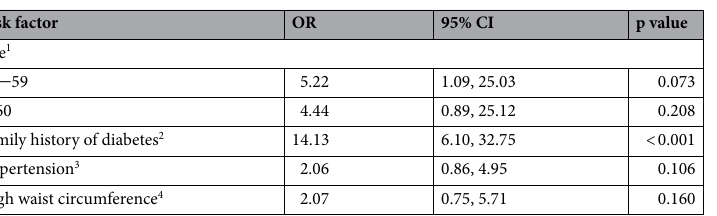
Table 2. Factors associated with T2D using multivariable logistic regression models. OR odds ratio, CI confidence interval, T2D type 2 diabetes. 1 Reference group = subjects aged 20 ‒ 39 years. 2 Based on immediate family members (father, mother, sister, or brother). Reference group = no family history of diabetes. 3 Classified as hypertensive (prior diagnosis of hypertension or systolic blood pressure greater than or equal to 140 mmHg or diastolic blood pressure of at least 90 mmHg or use of antihypertensive drugs). Reference group = non- hypertensive. 4 Normal defined as less than 80 cm and 90 cm for females and males, respectively. High was defined as at least 80 cm and 90 cm for females and males, respectively. Reference group = normal waist circumference.